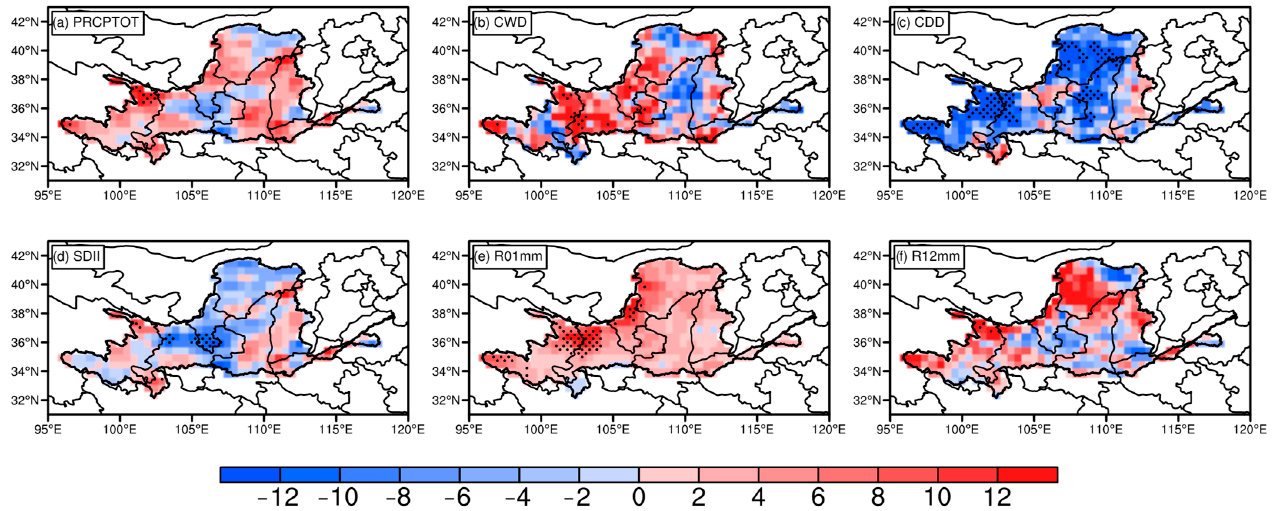
Figure 5. Spatial distribution of differences (defined as (Y − N) × 100/N; unit: %) in summer precip- itation indices under RCP4.5 over the YRB. ( a ) PRCPTOT; ( b ) CWD; ( c ) CDD; ( d ) SDII; ( e ) R01mm; ( f ) R12mm.